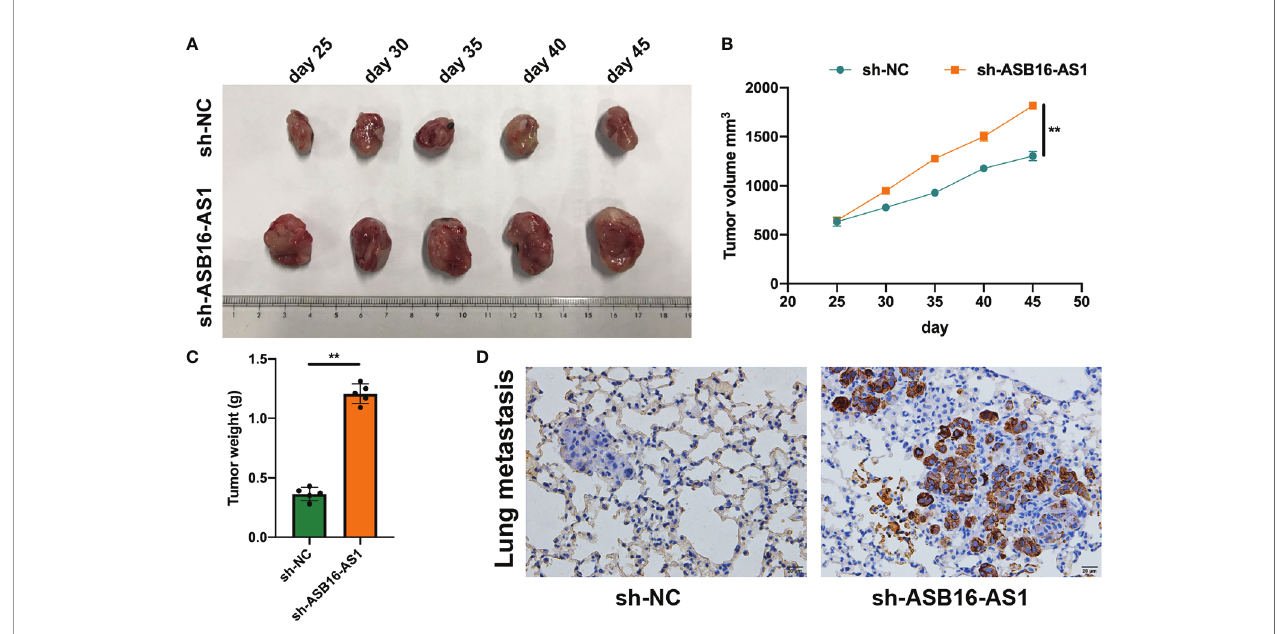
FIGURE 3 | ASB16-AS1 downregulation promotes renal cell carcinoma (RCC) cell growth and metastasis in vivo . Nonobese severe diabetic/severe combined immunode fi ciency mice (6 weeks old) were subcutaneously inoculated with 786-O cells (1×10 7 per tumor) pre-transfected with Sh-NC or Sh-ASB16-AS1 (N=5 per condition). (A) Representative images of inoculated tumors which are quanti fi ed by volume in (B) which shows tumor volume increasing over time in the Sh-ASB16-AS1 pre-treated cell condition. (C) Final tumor weights show that Sh-ASB16-AS1 pre-treated cells produces heavier tumors (N=5 per condition). (D) Representative histological images of lung metastasis. Data are presented as mean ± S.D, scale bars – 20 m m. **P <